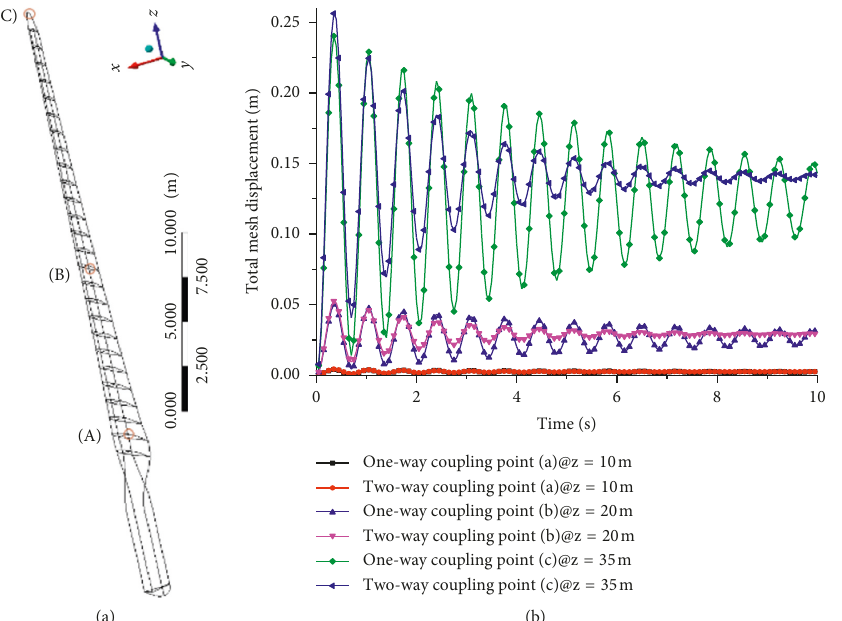
Figure 9: The displacement of three points on the blade surface under one- and two-way FSIs: (a) three points on the blade surface; (b) the displacement contrast of three